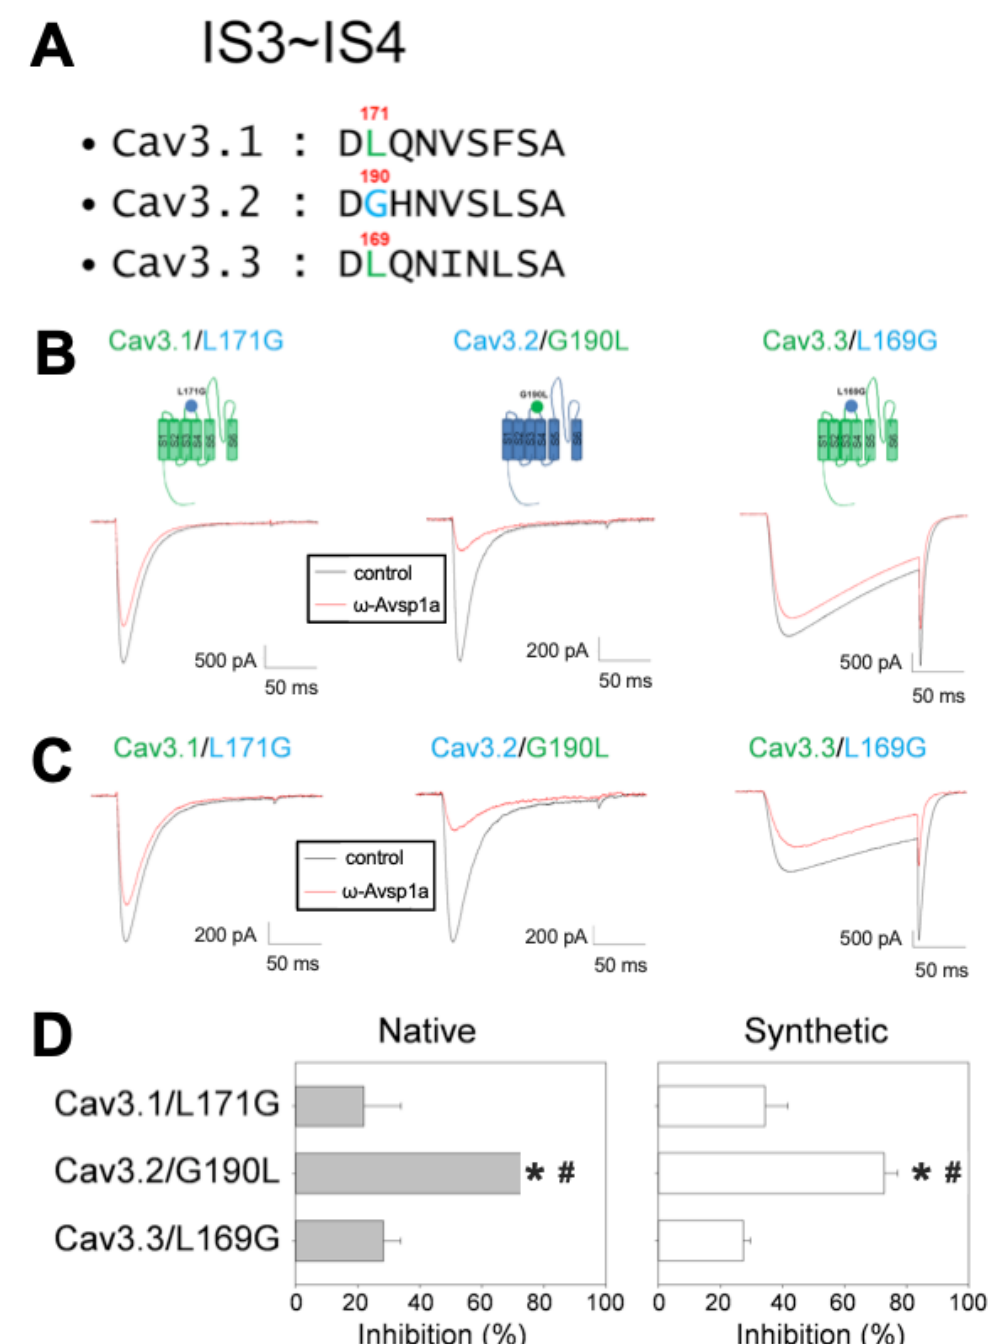
Figure 6. Activity of native and synthetic ω -Avsp1a on Ca V 3 channel chimeras expressed in HEK-293 cells. ( A ) Alignment of the sequences of the D1 S3-S4 extracellular loops of Ca V 3.1, Ca V 3.2 and Ca V 3.3. The G190 of Ca V 3.2 is an equivalent position to L171 in Ca V 3.1and L169 in Ca V 3.3. ( B ) Identification of residues involved in the inhibitory effect of native ω -Avsp1a. The native toxin concentration was 4.1 μM. n = 5 for Ca V 3.1/L171G and n = 4 for Ca V 3.2/G190L and Ca V 3.3/L169G. ( C ) Mutations of key residues in Ca V 3.1, Ca V 3.2 and Ca V 3.3 channels reversed the inhibitory effect of synthetic ω -Avsp1a. The concentration of synthetic ω - Avsp1a was 10 μM. n = 6, 9 and 4 for Ca V 3.1/L171G, Ca V 3.2/G190L and Ca V 3.3/L169G, respectively. ( D ) Quantification of the inhibitory effect of native and synthetic ω -Avsp1a on the mutant channels. * p < 0.001 vs. Cav3.1 and # p < 0.001 vs. Cav3.3 according to one-way ANOVA with Tukey ’ s post hoc test.